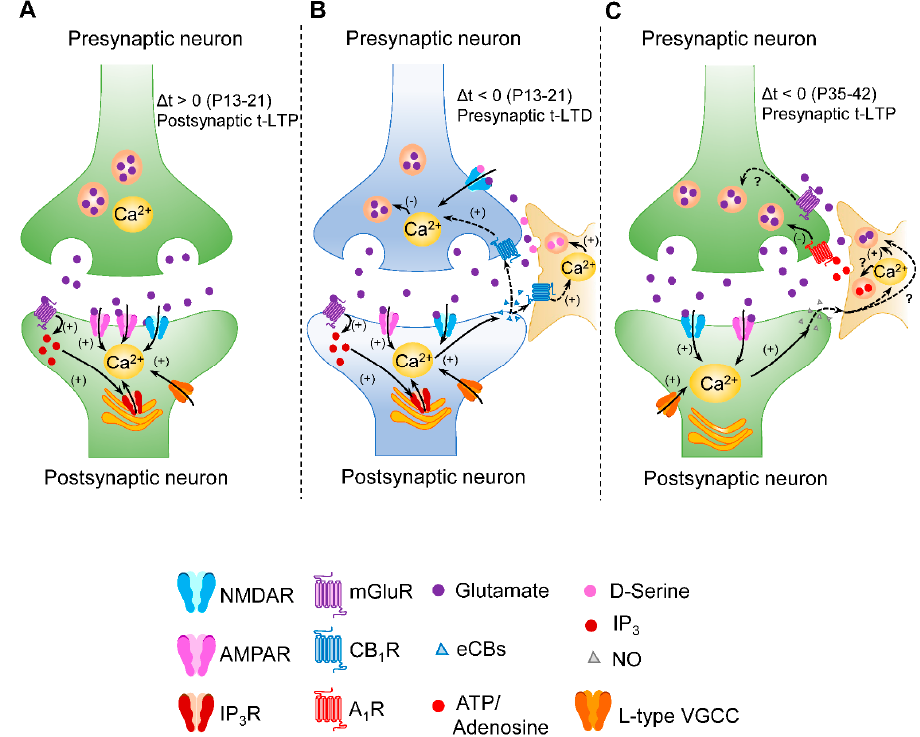
Figure 1. Schematic summarizing the role of mGluR I in different forms of STDP, showing that two different large sets of STDP forms could be proposed according to the underlying mechanism for coincidence detection: ( A ) In a classic model of Hebbian STDP, postsynaptic NMDARs are the main coincidence detectors (providing strong and brief Ca 2+ signals) that drive postsynaptic forms of t ‐ LTP and could also involve postsynaptic VGCCs, postsynaptic mGluRs and IP3R ‐ mediated increase in postsynaptic Ca 2+ [30,33,34,47,50]. This model does not fully support the mechanism underlying postsynaptic NMDAR ‐ dependent t ‐ LTD at horizontal layer 2/3 ‐ layer 2/3 synapses of the primary somatosensory cortex [36]. Consequently, more research needs to be performed. In turn, other find ‐